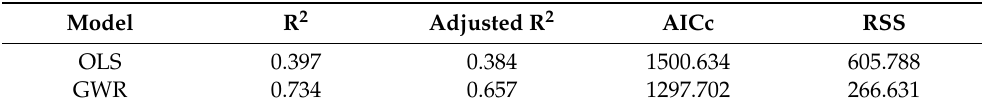
Table 5. Ordinary least square (OLS) and Geographically weighted regression (GWR) model perfor-